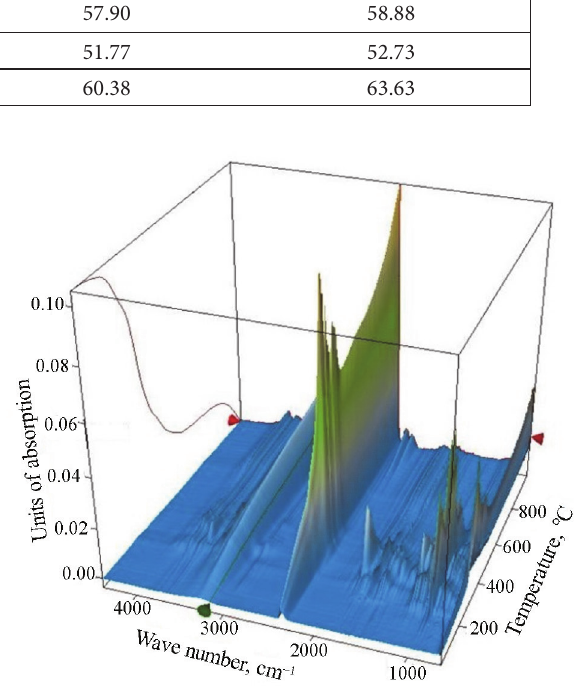
Figure 6. 3D view of all detected infrared spectra obtained by gas leaking from THR01 thermal analysis, surface temperature